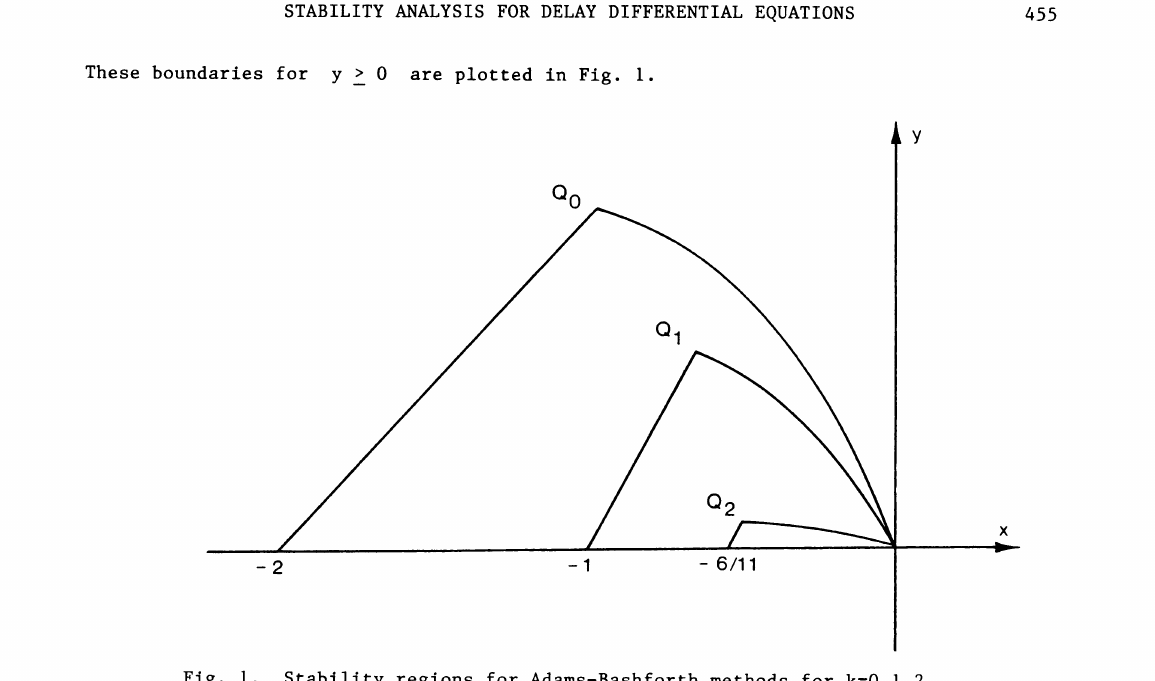
Fig. i. Stability regions for Adams-Bashforth methods for